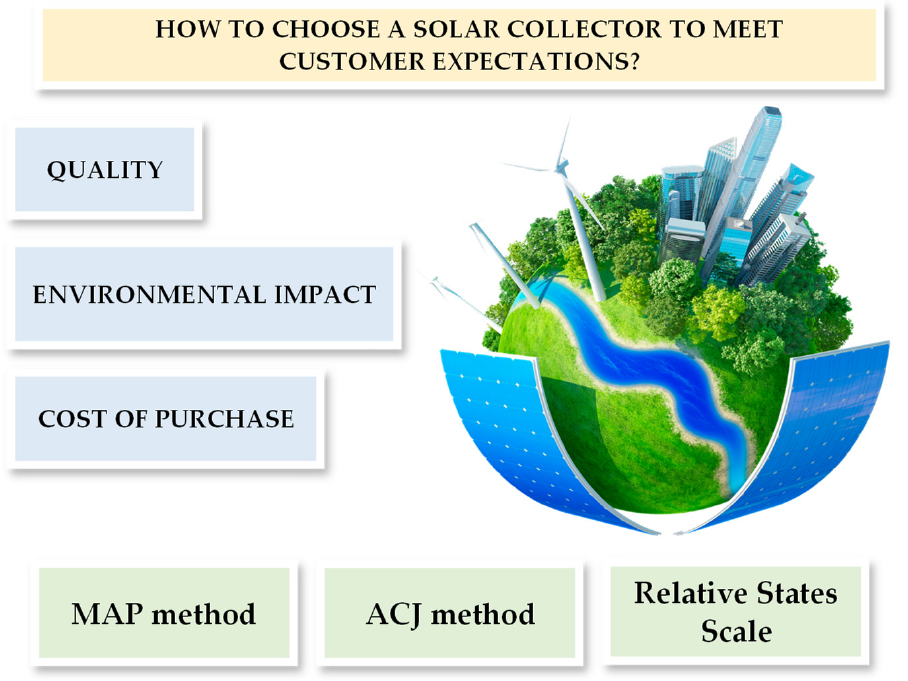
Figure 1. General concept of method.